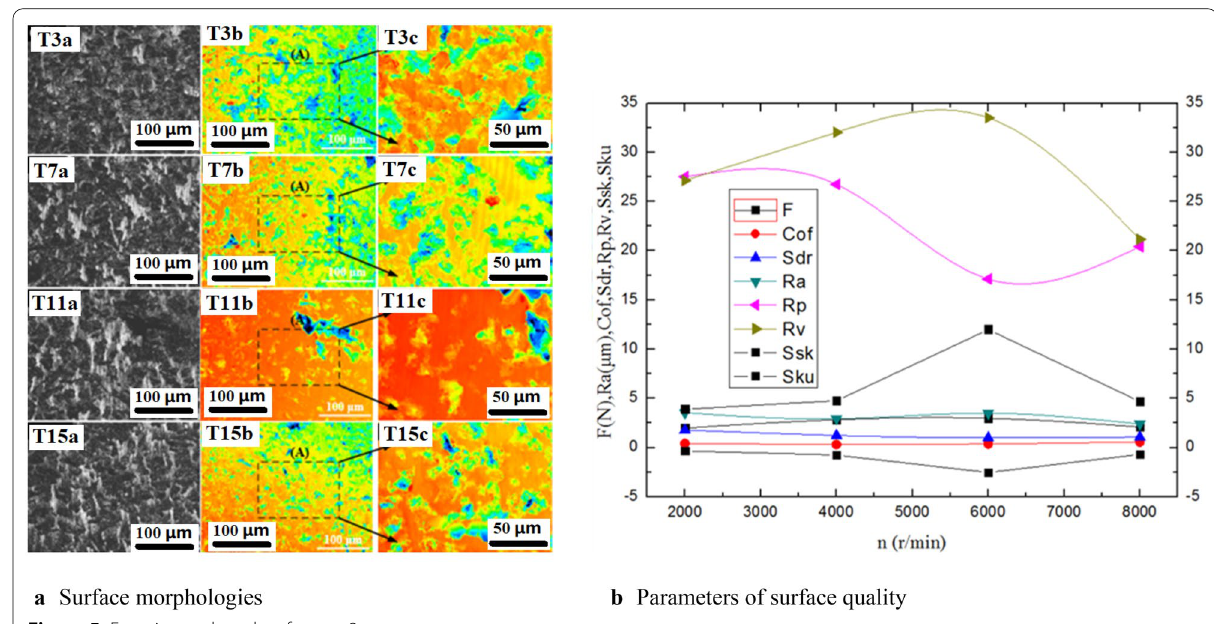
Figure 5 Experimental results of group 3